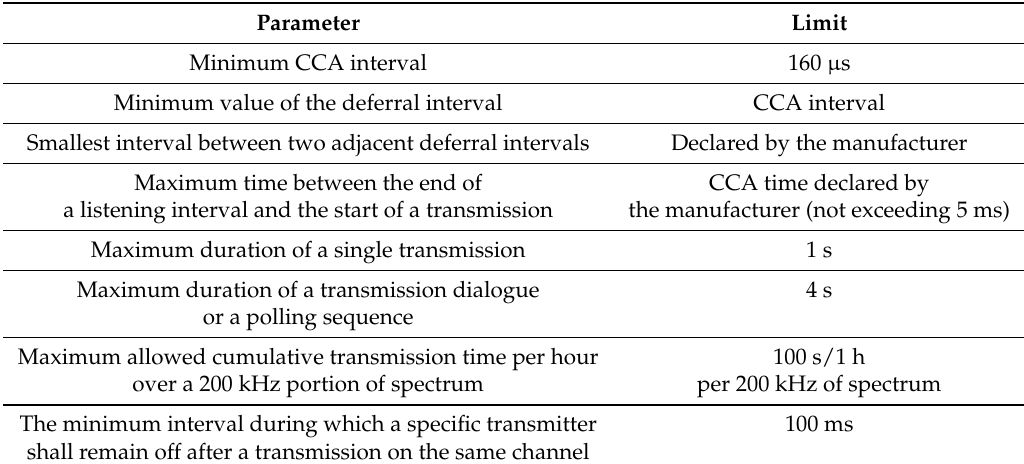
Table 2. Polite spectrum access timing